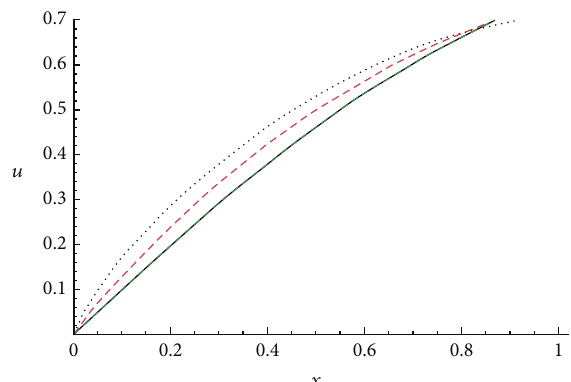
Figure 2: Plots of the approximate solution for different values of 𝛼 and the exact solution for (23).